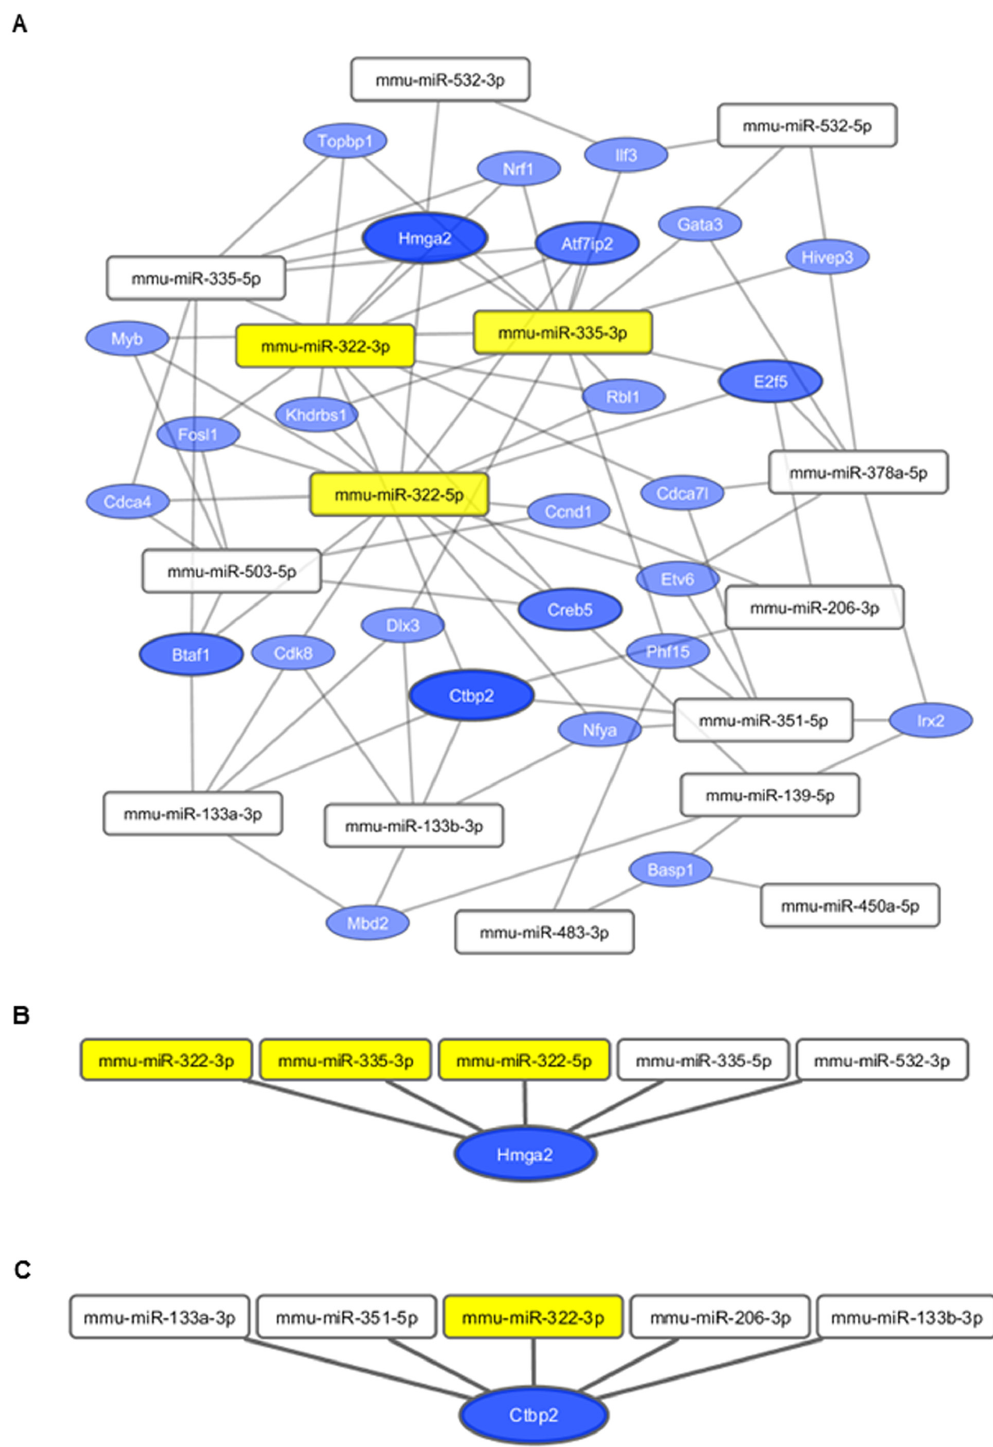
Fig 6. Cooperative targeting of transcription factors. (A) MiRNA-target network of transcription factors which are targeted by at least three miRNAs. Edges connect the respective miRNA with its predicted and inversely associated transcription factors which were represented by nodes. The bigger the size of the node the more edges did the target have indicating collective targeting by several miRNAs. MiRNAs highlighted by yellow had the highest number of collectively targeted transcription factors. (B) Hmga2 and its targeting miRNAs, (C) Ctbp2 with targeting miRNAs.